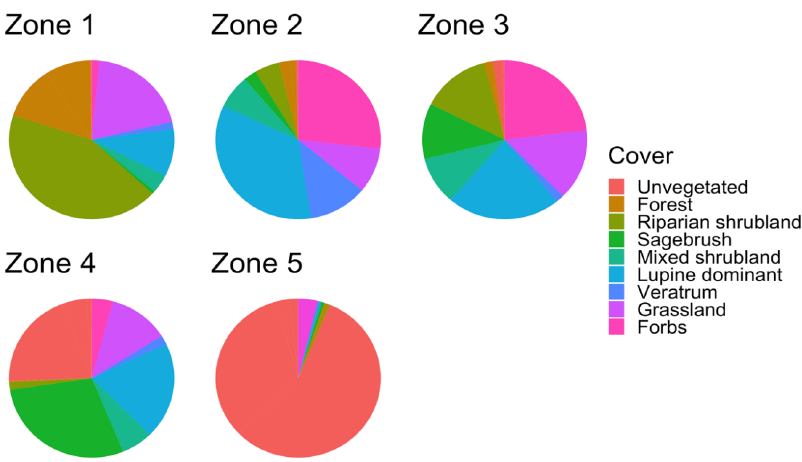
Figure 10. The proportion of area covered by each plant functional type for each spatial zone derived from clustering NDVI time series from satellite imagery with the Ward method. Plant functional types were obtained from Falco et al. [15]. A table with the percent coverage of each plant functional type by zone is included in the supplementary materials (Table S4).